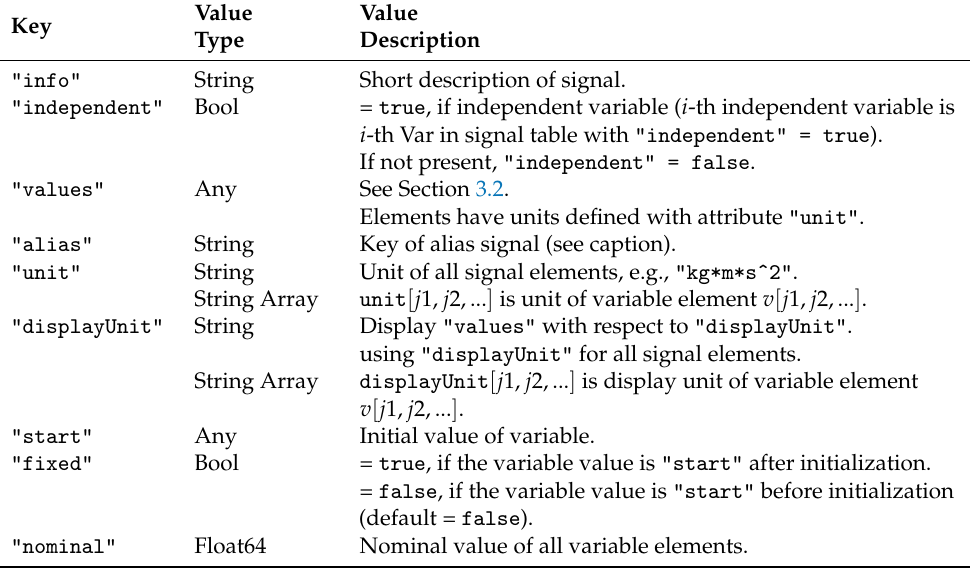
Table A1. Predefined attributes for Var dictionaries. Either "values" or "alias" must be present. During the construction of a signal table, all Var with the attribute "alias" are automatically pro- cessed and obtain a "values" key that references the "values" key of the alias variable. As a result, "values" is present for all Var dictionaries after the construction of a Signal Table. All other keys are